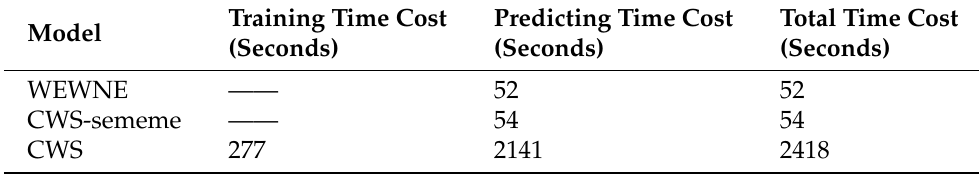
Table 8. The time cost of different